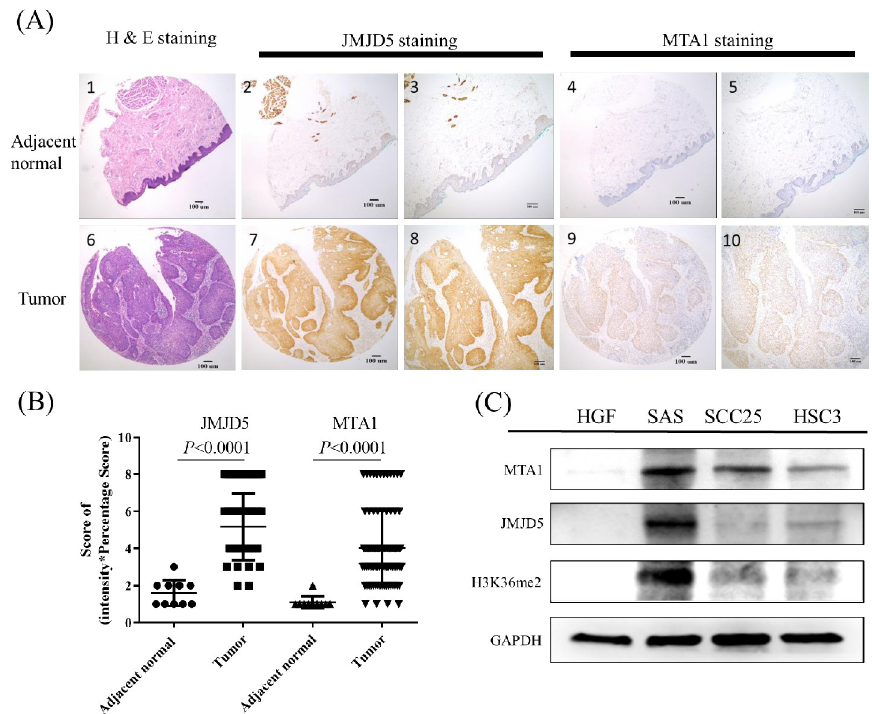
Fig 1. JMJD5 and MTA1 were overexpressed in oral cancer. Representative samples scored for high or low expression for JMJD5 and MTA1 IHC results are shown. (A1) H&E stain for normal tissues adjacent to the tumor (magnification 40x); (A2) JMJD5-stained in normal tissues adjacent to the tumor (magnification 40x); (A3) JMJD5-stained in normal tissues adjacent to the tumor (magnification 100x); (A4) MTA1-stained in normal tissues adjacent to the tumor (magnification 40x); (A5) MTA1-stained in normal tissues adjacent to the tumor (magnification 100x); (A6) H&E stain for OSCC tumor tissue (magnification 40x); (A7) JMJD5-stained in OSCC tumor tissue (magnification 40x); (A8) JMJD5-stained in OSCC tumor tissue (magnification 100x); (A9) MTA1-stained in OSCC tumor tissue (magnification 40x); (A10) MTA1-stained in OSCC tumor tissue (magnification 100x). (B) JMJD5 and MTA1 were highly expressed in oral cancer tissues. The score was defined intensity score x percentage score. Data are expressed as mean ± standard deviation. P < 0.05 (Student’s t-test) is represented significance difference. (C) Both JMJD5 and MTA1 were high expressed in the oral cancer cell lines than in normal cells. HGF as a primary cultured normal human gingival fibroblast cell. H3K36me2, the di-methylation at the 36th lysine residue of the histone H3